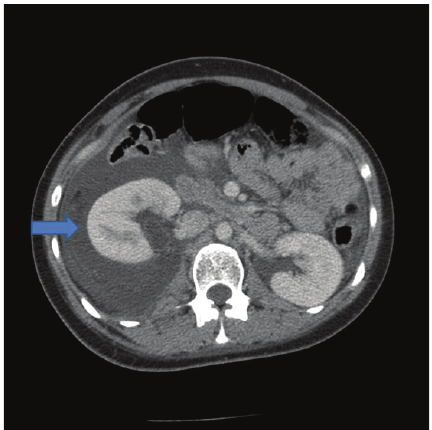
Figure 1: CT scan of abdomen on admission. Blue arrow indicates presence of